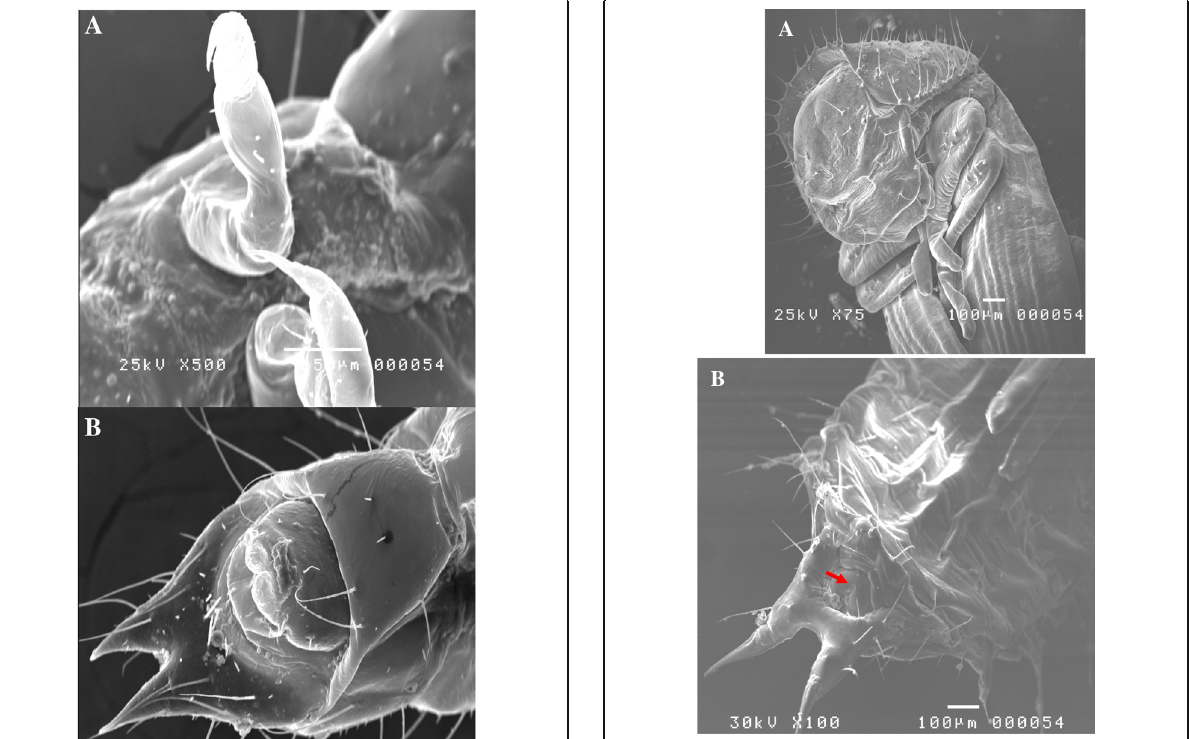
Fig. 10 a SEM of ventral view of mature formed pupa showing the head is depressed beneath the pronotum. b SEM of ventral view of the last abdominal segments of male pupa showing its papillae look like fingertips ( red arrow )